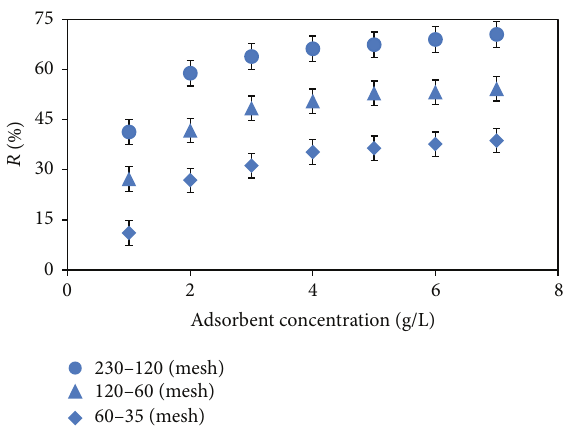
Figure 2: Effect of adsorbent concentration and mesh size (pH: 3, −1 , 𝑇 : 293 K). 𝐶 𝑜 : 50 mgL